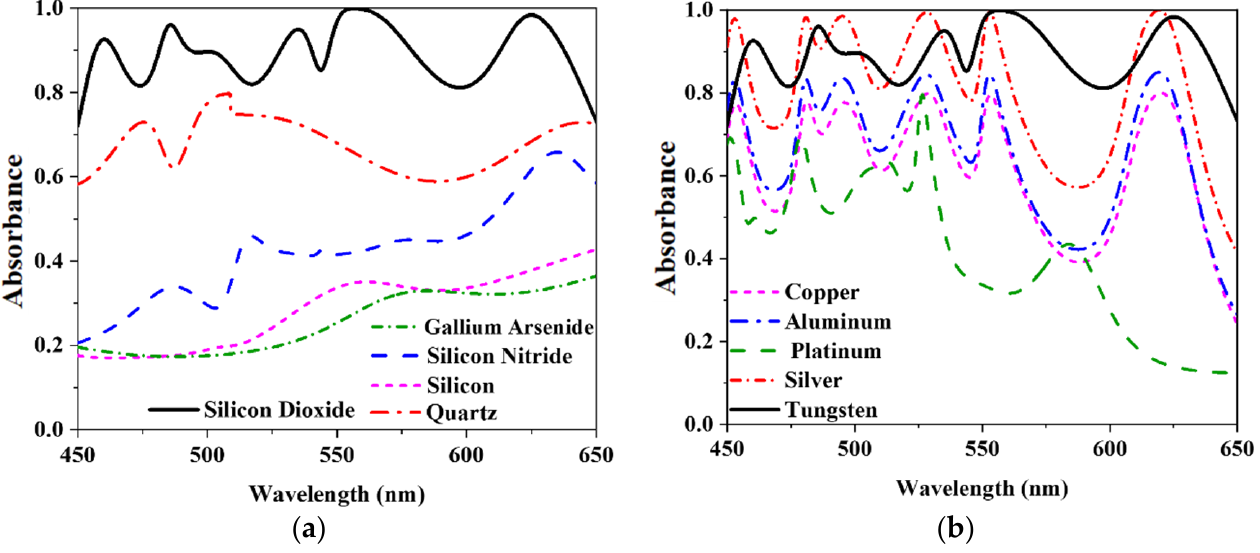
Figure 7. The absorbance compared with ( a ) several dielectric layers and ( b ) various types of metals.